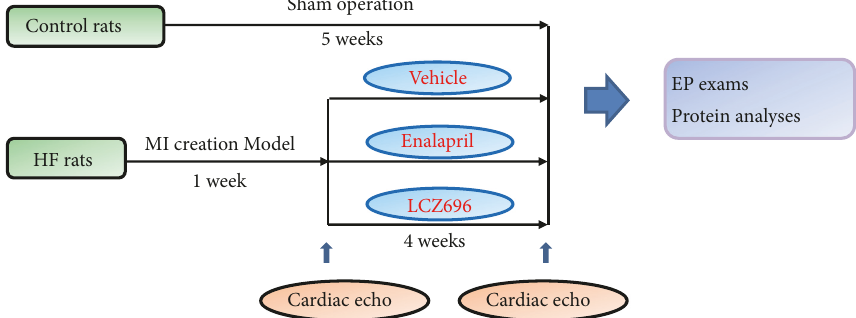
Figure 1: Medical therapy protocol of heart failure (HF)-MI rats. Rats that survived one week after MI created were randomly assigned to receive vehicle, enalapril, or LCZ696 therapy. After 4-week medical therapy, HF-MI rats received electrophysiological (EP) exams to test ventricular arrhythmia (VA) inducibility and then were sacrificed for protein analyses. Sham rats were subjected to EP exams and protein analyses without medical